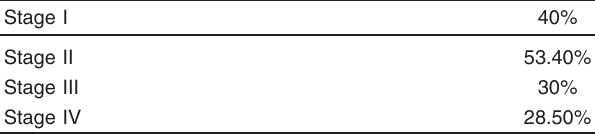
Table 5 The distribution of metabolic syndrome between the Global Initiative for Chronic Obstructive Lung Disease stages